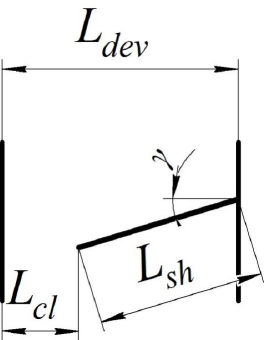
Figure 2. The basic elements of the shelf device construction.